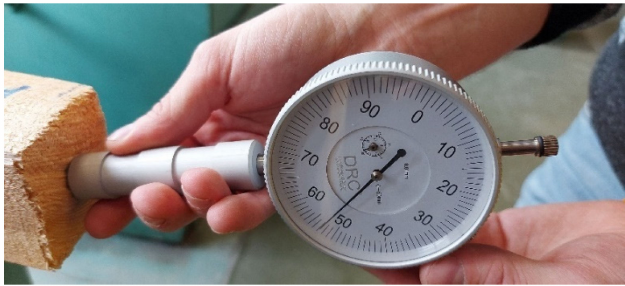
Figure 9. Reading from the needle recess in the wooden element along